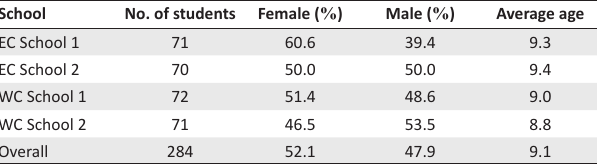
TABLE 4: Receptive word knowledge test of high-frequency words: Participants per school, gender distribution and average age (in November 2016). School No. of students Female ( % )